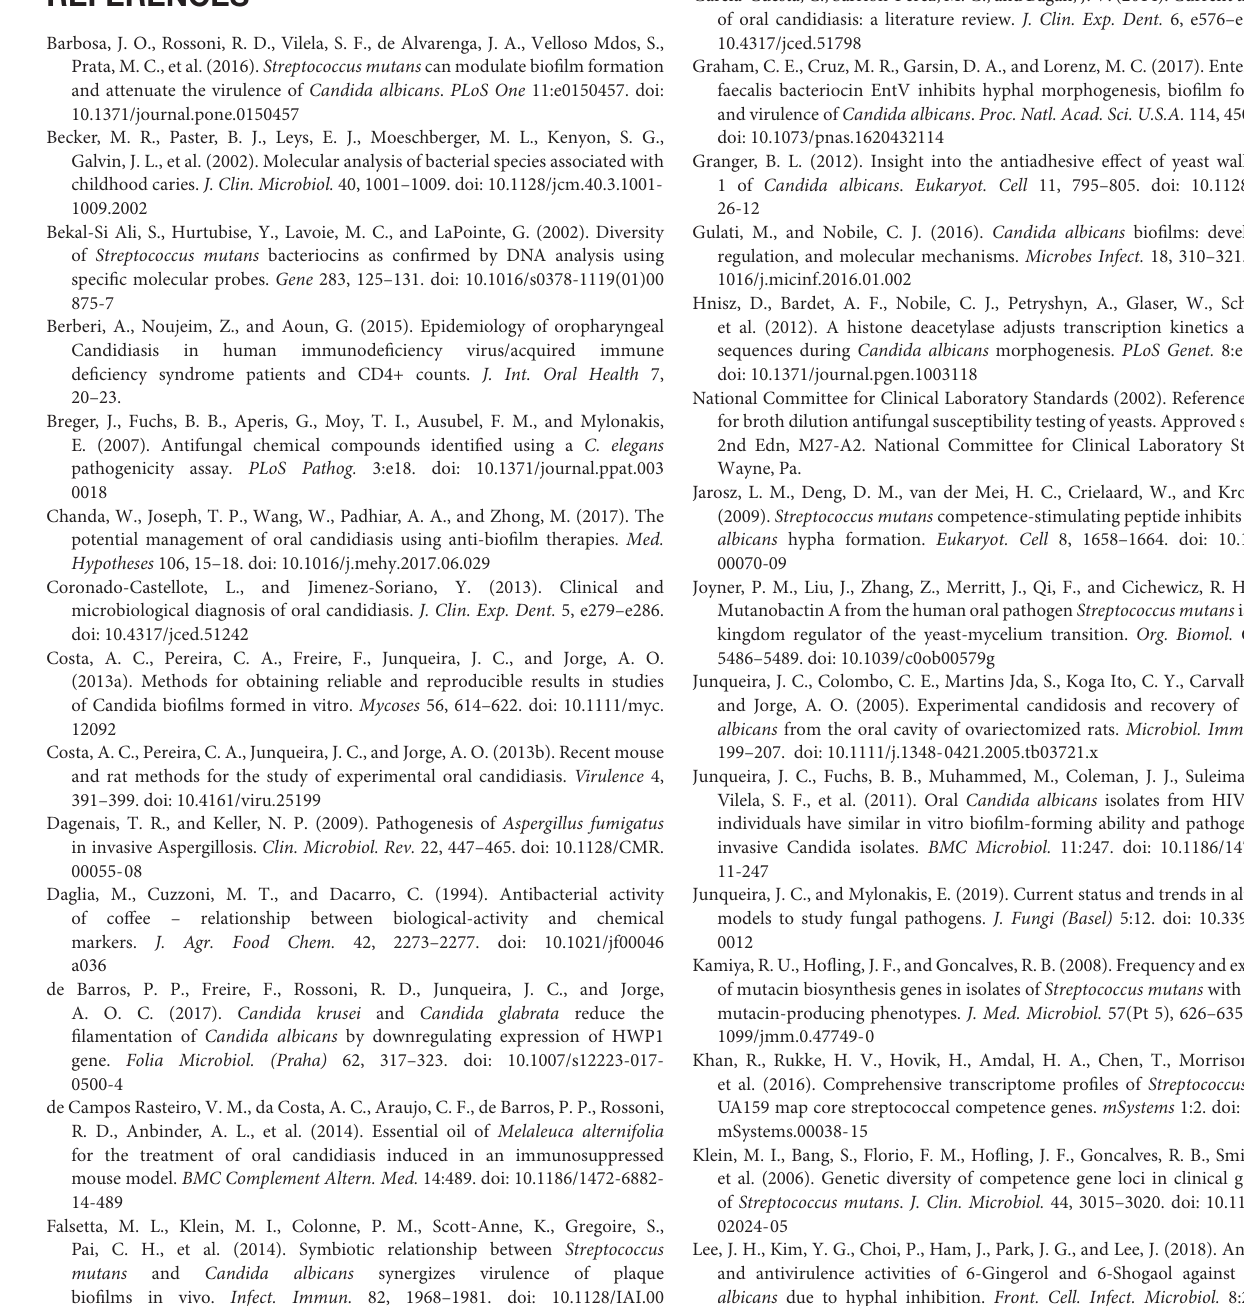
FIGURE S4 | Measured pH in the in vitro filamentation assay. Median and SD of pH values in the medium for each well obtained in the following groups: non-treated control group, SM-F1 5 mg/mL, SM-F1 10 mg/mL, SM-F1 15 mg/mL, SM-F2 5 mg/mL, SM-F2 10 mg/mL, and SM-F2 15 mg/mL (H). FIGURE S5 | Chromatograms obtained by gas chromatography coupled to mass spectrometry (GC-MS). Comparisons between the SM-F1 fraction (red line) and control group of BHI media (black line). The black arrows indicate the peaks that